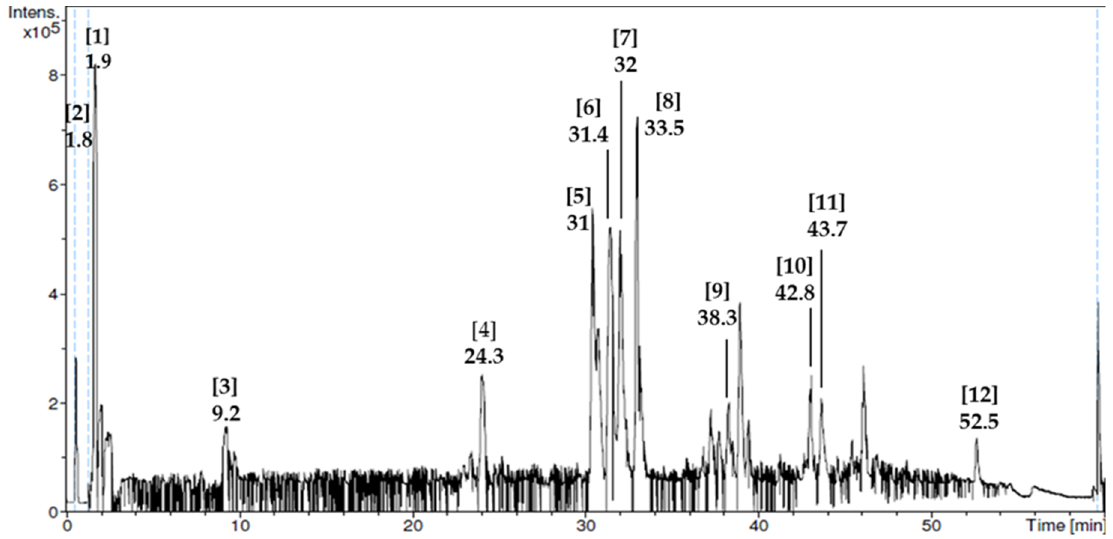
Figure 1. LC–MS chromatogram of royal jelly (peak assignments are listed in Table 2).